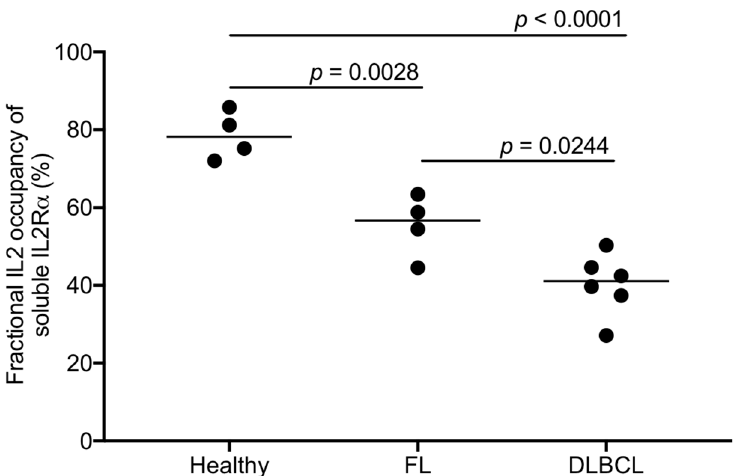
Figure 3. Fractional IL2 occupancy of soluble IL2Ra in healthy individuals and lymphoma patients, as analyzed by LIRECAP assay. Fractional occupancy of soluble IL2Ra by IL2 was measured using the LIRECAP assay using serum from healthy subjects and patients with Follicular lymphoma (FL) or Diffuse large B cell lymphoma (DLBCL). Data was compared using one-way ANOVA (Tukey’s test).